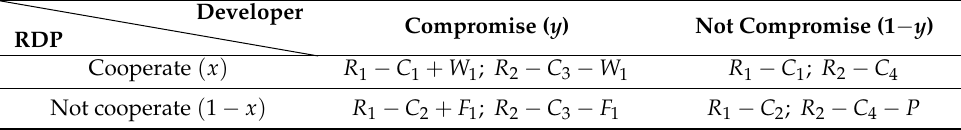
Table 3. Matrix of benefits for RDP and the hydropower